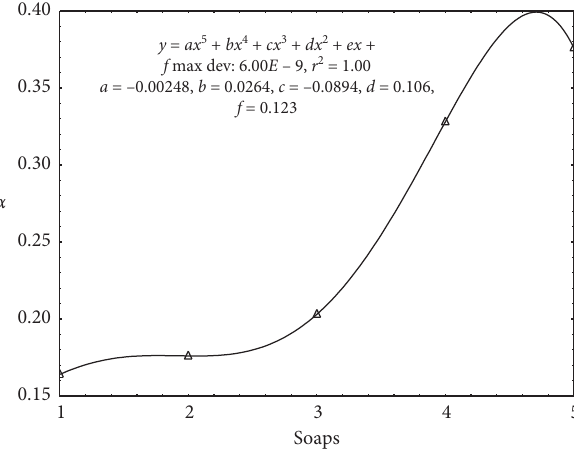
Figure 5: Variation of α versus 1 )